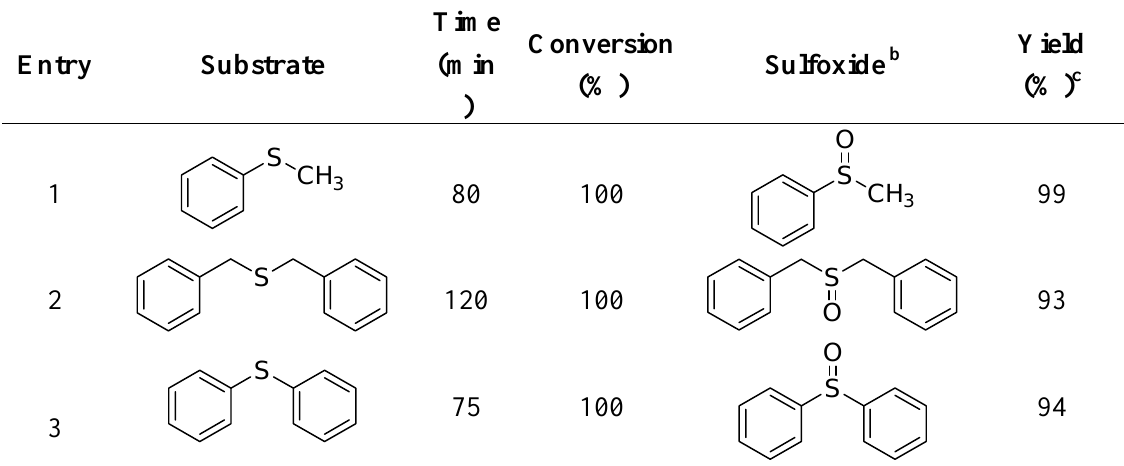
Table2. Oxidation of sulfides to sulfoxides with hydrogen peroxide a